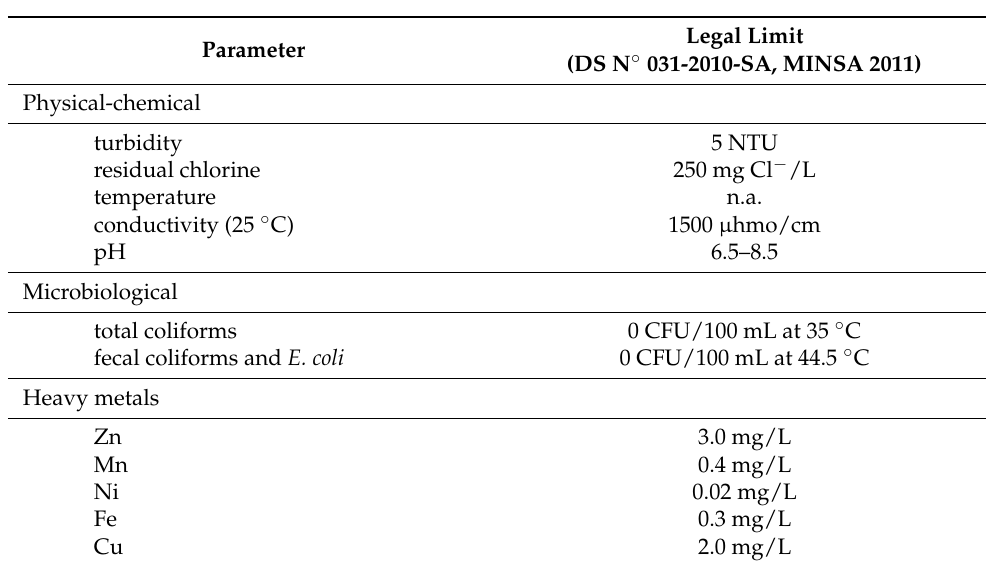
Figure 1. Location of the district of Ilave in the province of El Collao ( a ) and location of the ten sampling points ( b ), located in the city of Ilave, Region of Puno, Peru. Table 2. Legal limits allowed in water used for human consumption according to the Peruvian regulation (DS N ◦ 031-2010-SA)